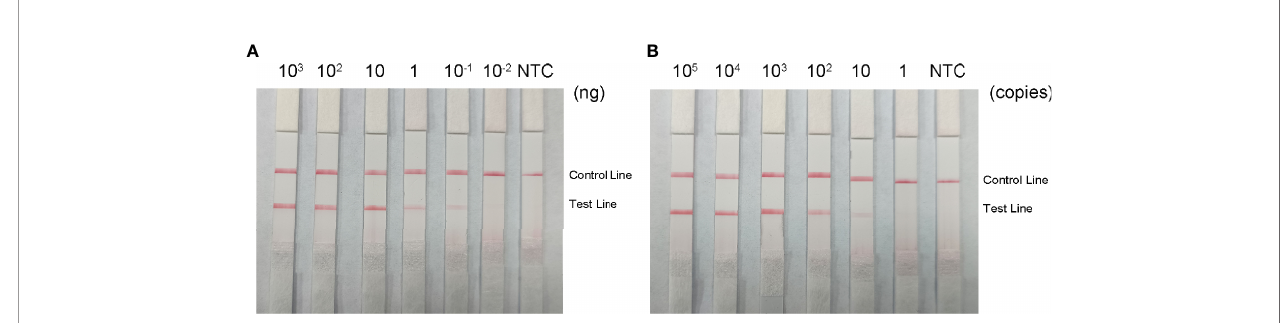
FIGURE 9 | Sensitivity of the RPA-LFS system. (A) LFS results for different amounts of RPA carrying rmpA2 of Klebsiella pneumoniae genomic DNA. The amount added to the RPA reaction (ng/ m L) is shown at the top of each band. The ampli fi cation template is the supernatant obtained from the boiling method of Klebsiella pneumoniae carrying rmpA2 (B) Images of the LFS results of RPA ampli fi cation using different amounts of recombinant plasmid Ss-mb-pMD ™ 19-T. The amount added to the RPA reaction (in copies) is shown at the top of each strip. The NTC strip is the control without template. The positions of the control and test lines are shown on the right side of the image. Reactions were performed at 37°C for 30 minutes.